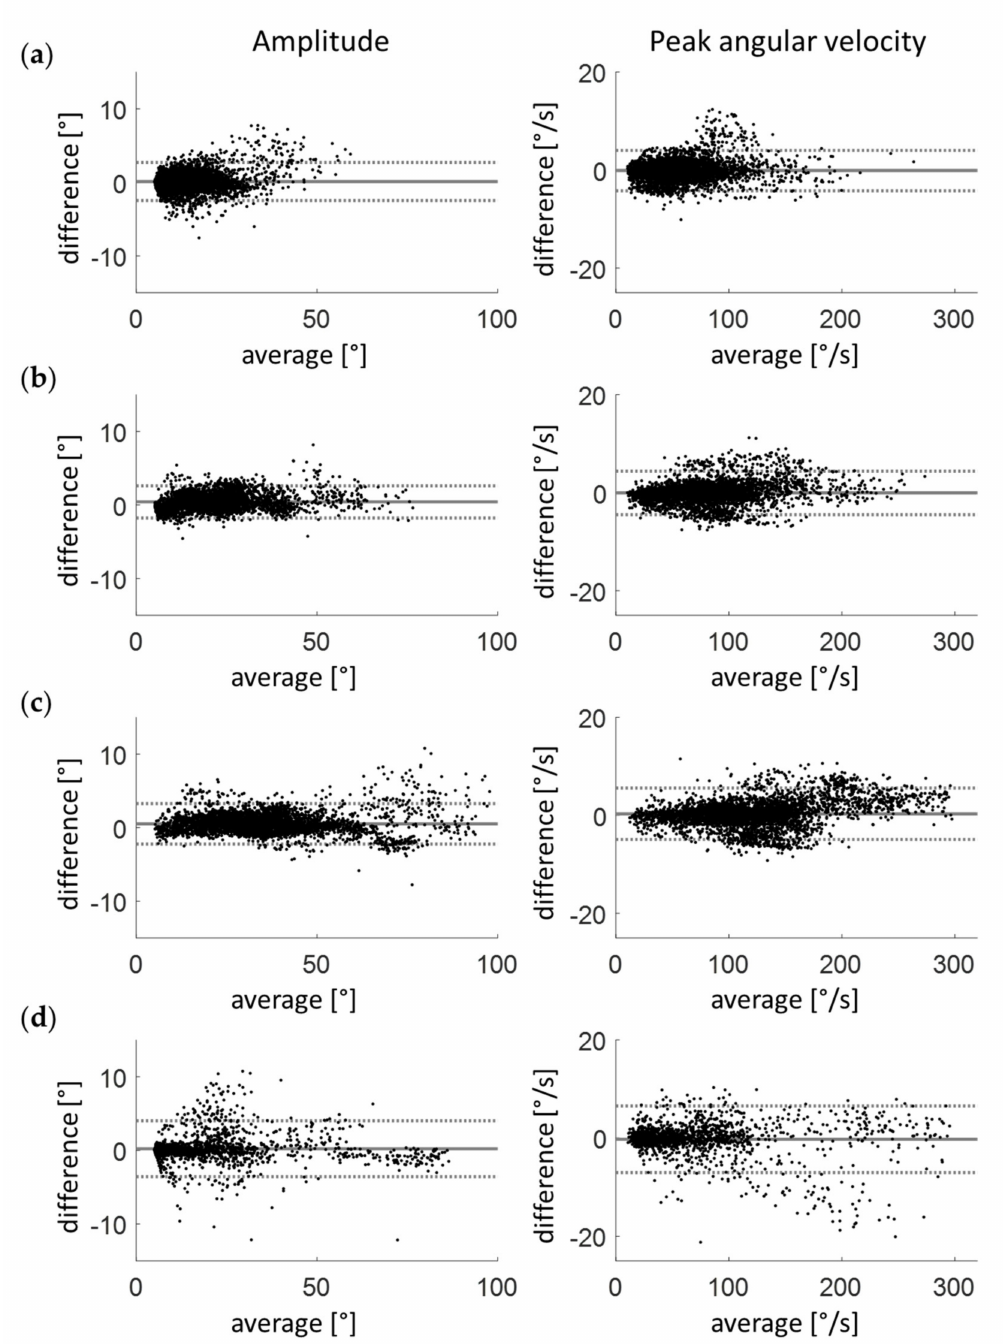
Figure 4. Bland–Altman plots are shown with the arm swing amplitude and peak angular velocity at 2 km / h ( a ), 3 km / h ( b ), and 4 km / h ( c ) for the healthy adults and at the preferred speed ( d ) for patients with Parkinson’s disease. On the x-axes, the average of the IMU and optical results are presented, and on the y-axes the di ff erences between IMU and optical results (IMU-optical) are